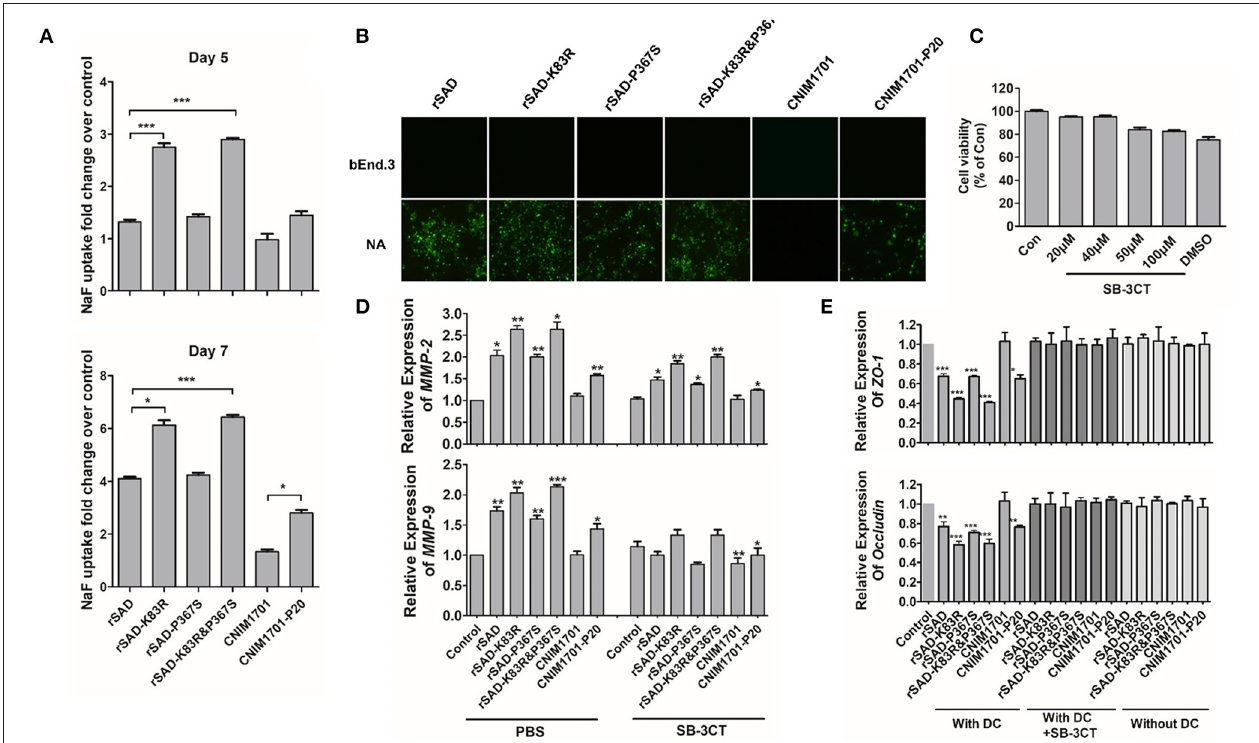
FIGURE 5 | The impact of different viruses on the MMPs and permeability of the BBB. (A) C57BL/6 mice were infected with 104 gene copies of RABV by intracranial (i.c.) injection. At day 5 or 7 p.i., the absorption of NaF in the cerebrum was measured. (B) The bEnd.3 cells were infected with rSAD, rSAD-K83R, rSAD-P367S, or rSAD-K83R&P367S at MOI of 1, respectively. The fluorescence microscope image (magnification × 200) of cells were stained with FITC-labeled anti-rabies virus N protein antibodies at 48h after infection. NA cells infected with each virus were included as positive controls. (C) Cell viability of DCs after treatment with SB-3CT determined by MTT assay. (D) The mRNA level of MMP-2/9 in RABV-infected DCs with or without the treatment of SB-3CT or PBS. (E) The mRNA level of ZO-1 and occludin in response to the indicated treatment in bEnd.3 cells. bEnd.3 cells were co-cultured with DCs, RABV-infected DCs, or DCs + SB-3CT. Significance of differences between the indicated group was assessed by the unpaired t -test. * p < 0.05; ** p < 0.01; *** p <